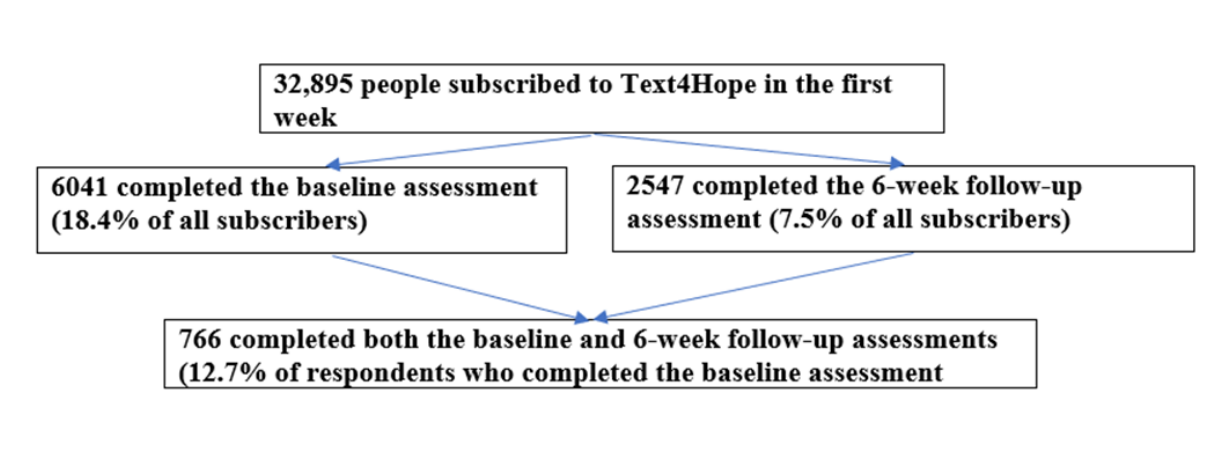
Figure 1. Flowchart of subscriber participation from baseline to the sixth